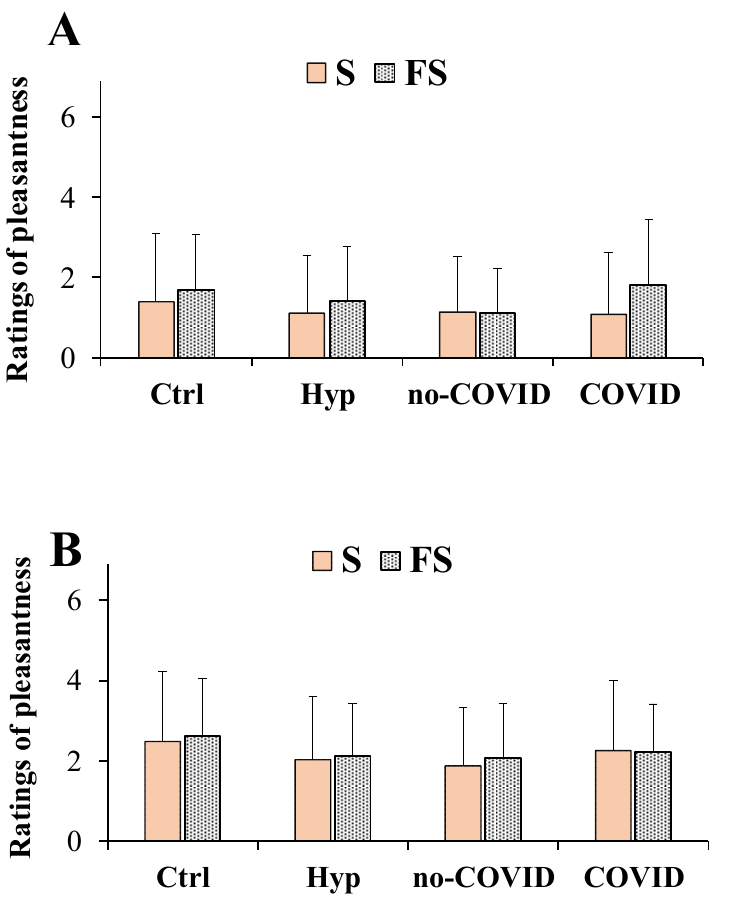
Figure 2. Ratings of pleasantness dimension measured in total patients with hyposmia (Hyp, n = 57), subjects without (no-COVID, n = 34) or with (COVID, n = 23) post-acute coronavirus syndrome compared to healthy controls (Ctrl, n = 91), in response to saline solutions obtained with pure sea salt (S) and flavored salts (FS) at the concentrations of 0.1 g/mL (high dose) ( A ) and 0.04 g/mL (low dose) ( B ). Data are presented as mean values and standard deviations. For FS, each value of the taste dimensions was obtained as the mean of participant responses to the three different commercial FS samples. Significant differences among the four different groups of subjects (as between factors) in relation to the type of salt (S and FS as within factor) were calculated using two-way repeated measures ANOVA.